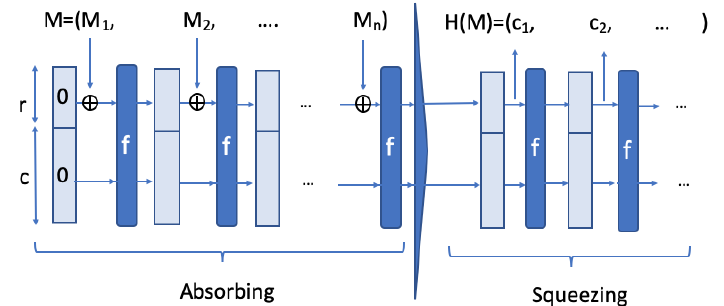
Figure 1. Message M is broken into n consecutive r bit pieces M 1 ,..., M n . The output, after applying the permutation f several rounds, is denoted by c 1 , c 2 ,.... The size of the state on which the function f works, is called the rate r , while the capacity c denotes the size of the part that is untouched by input or output